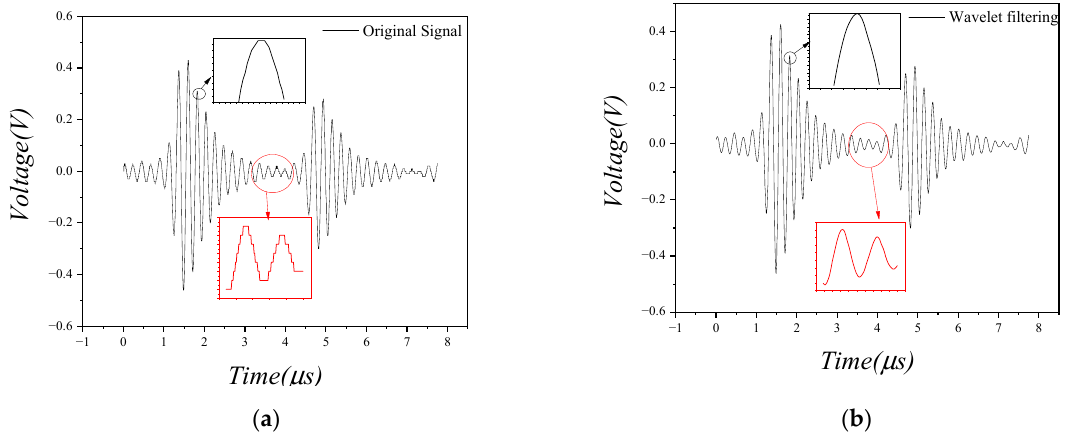
Figure 11. ( a ) Original ultrasonic echo signal, and ( b ) the signal after wavelet filtering. By performing EMD again after the wavelet transform as shown in Figure 12, the phenomenon of “Mode Mixing” was eliminated, the original information of the signal was preserved, and the noise was filtered out. Figure 13a shows that wavelet filtering could effectively reduce the amplitude of the oscillation after the Hilbert transformation. However, minor oscillations became apparent, which may increase the computational burden